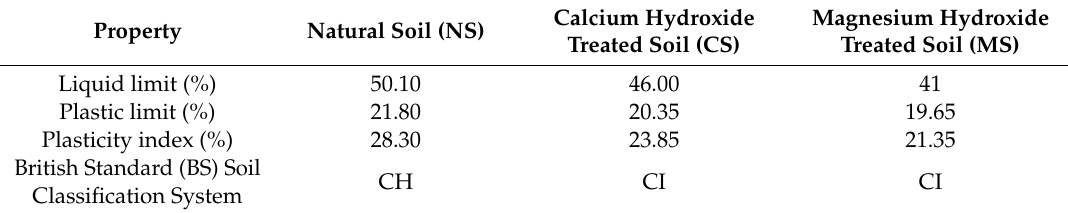
Table 1. Atterberg limits of the untreated and nanoparticles-treated residual soil samples. Calcium Property Natural Soil (NS)